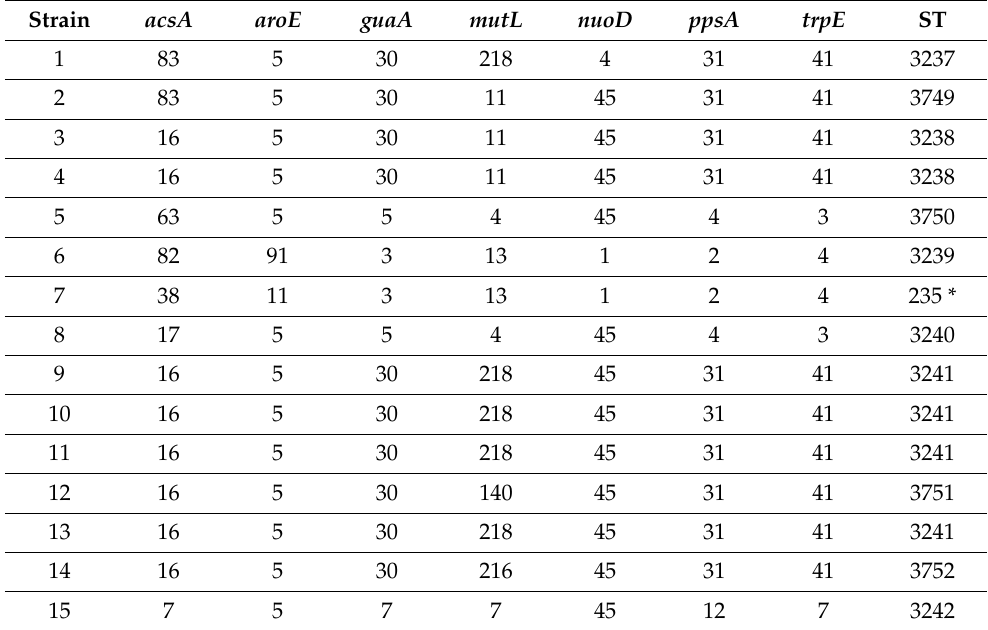
Table 2. Allelic profile, sequence types, and haplotypes of the MexAB-OprM efflux pump repressor genes ( mexR, nalC, nalD ) of the analysed P. aeruginosa strains. Strain acsA aroE